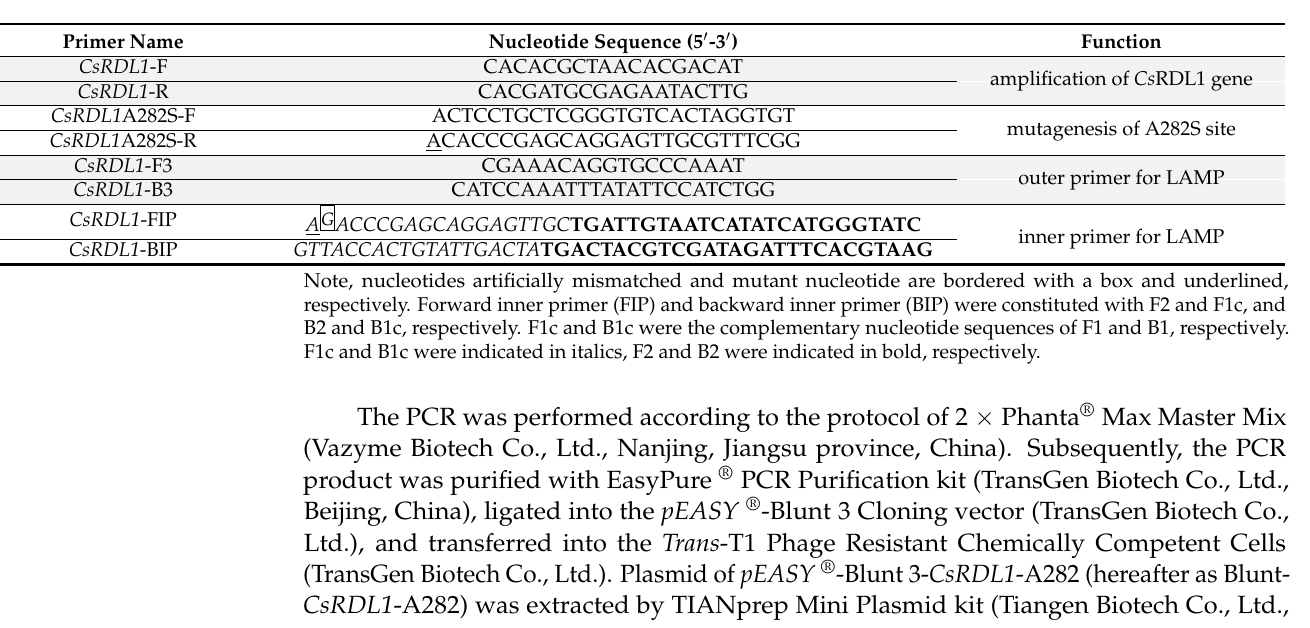
Table 1. Amplification of CsRDL1 gene. Table 1. Primers used in this